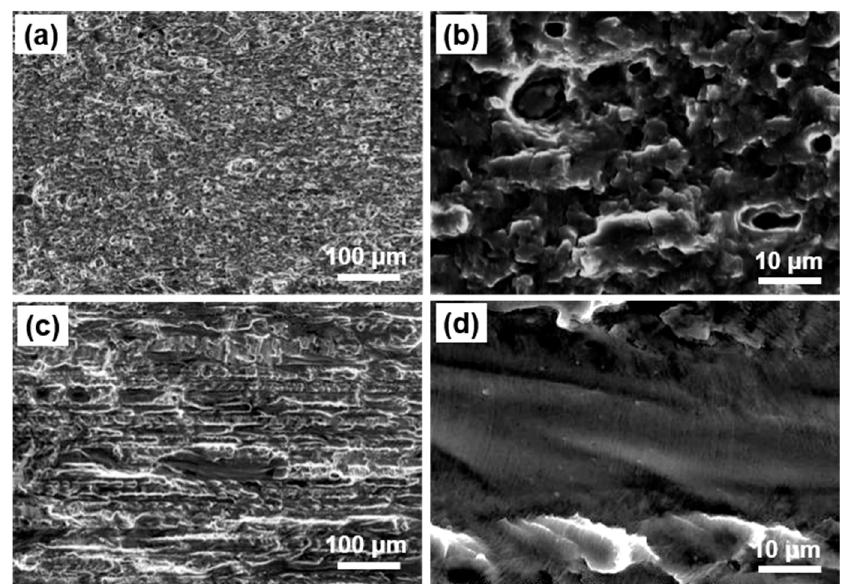
Figure 6. SEM fractography of near-threshold region in Al-Cu-Li-Mg-Zr alloys: ( a ) low magnification and ( b ) high magnification of High Fe alloy; ( c ) low magnification and ( d ) high magnification of Low Fe alloy.